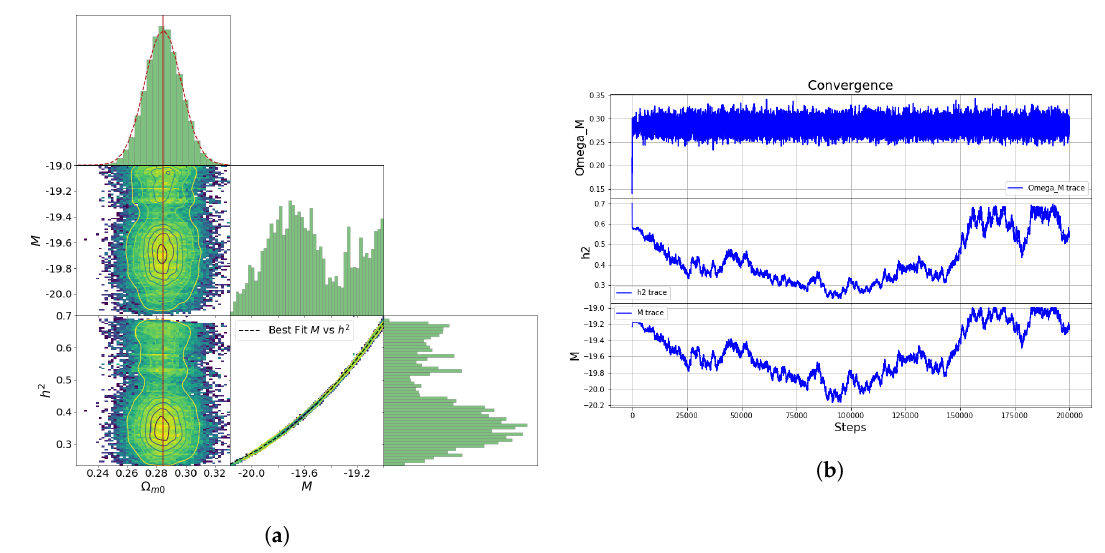
Figure 15. MCMC analysis assuming M as a free parameter in GR. ( a ) Posterior probabilities densities. ( b ) Evolution of values with